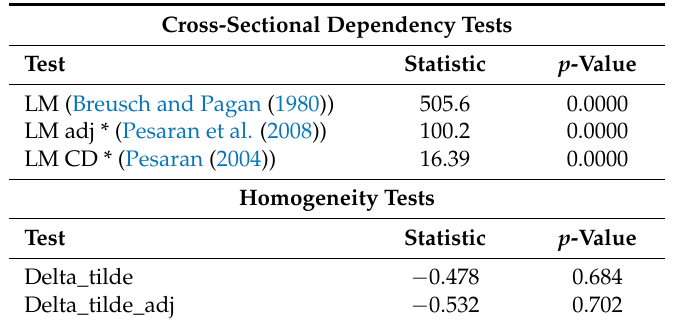
Table 3. Results of cross-sectional dependence and homogeneity